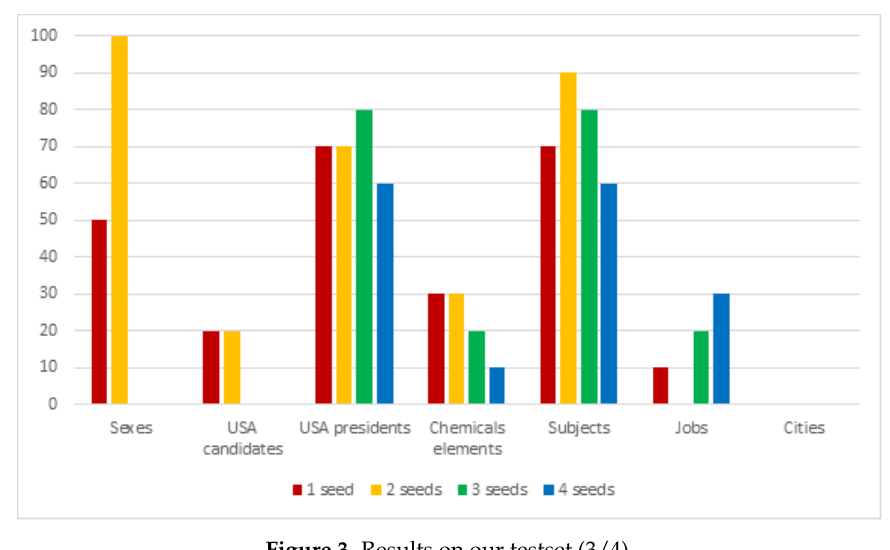
Figure 2. Results on our testset (2/4).